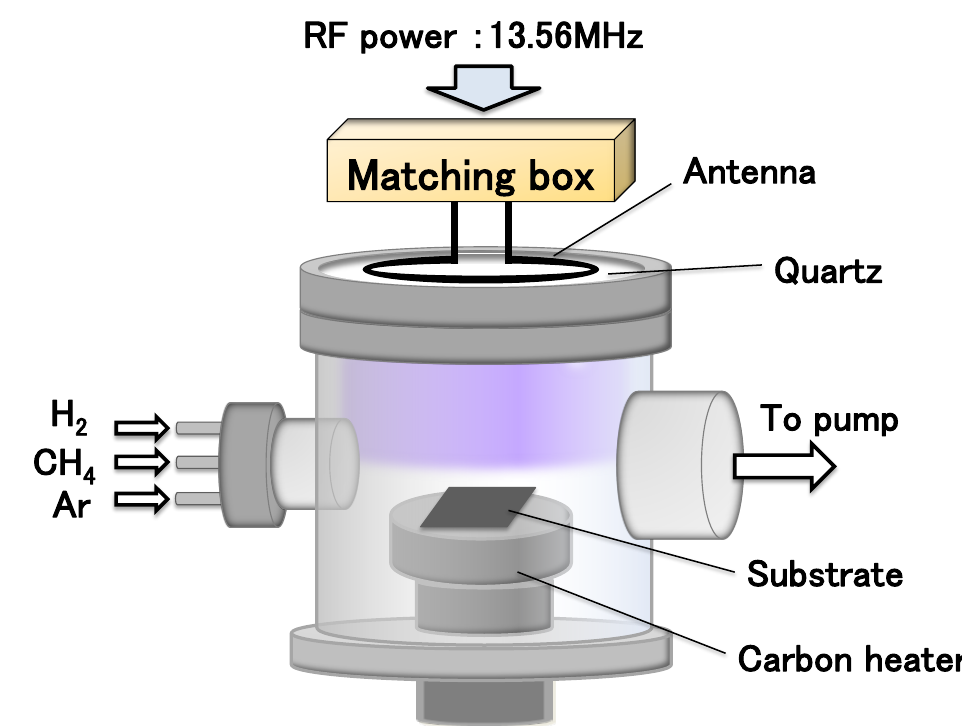
Figure 1. Schematic diagram of the ICP reactor.